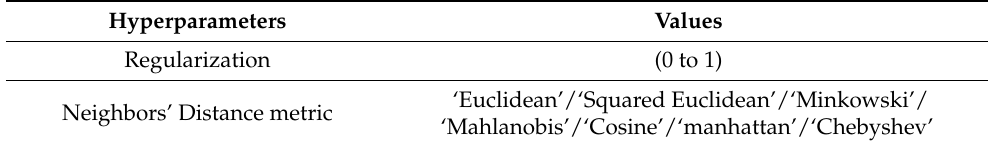
Table 3. MLR HyperParameters range used for searching the